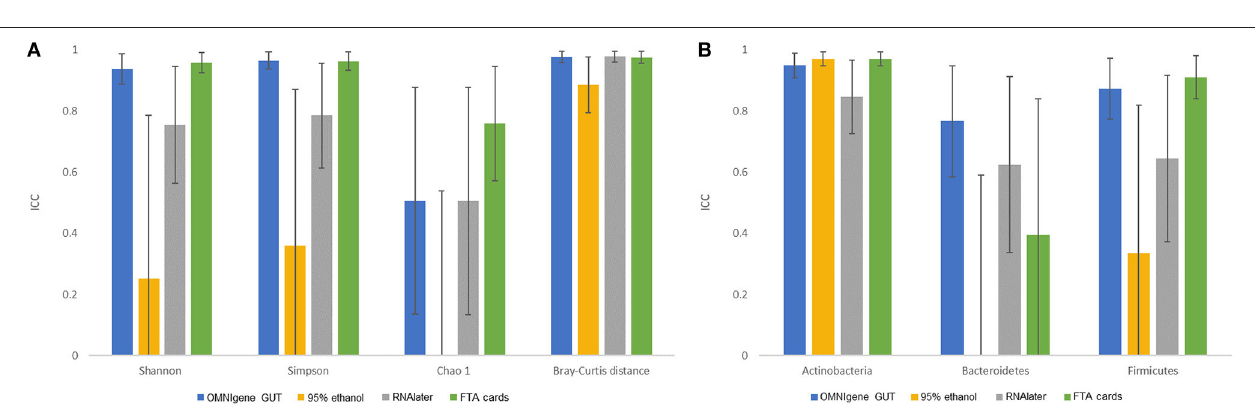
largest number of identical metabolites ( n = 112;